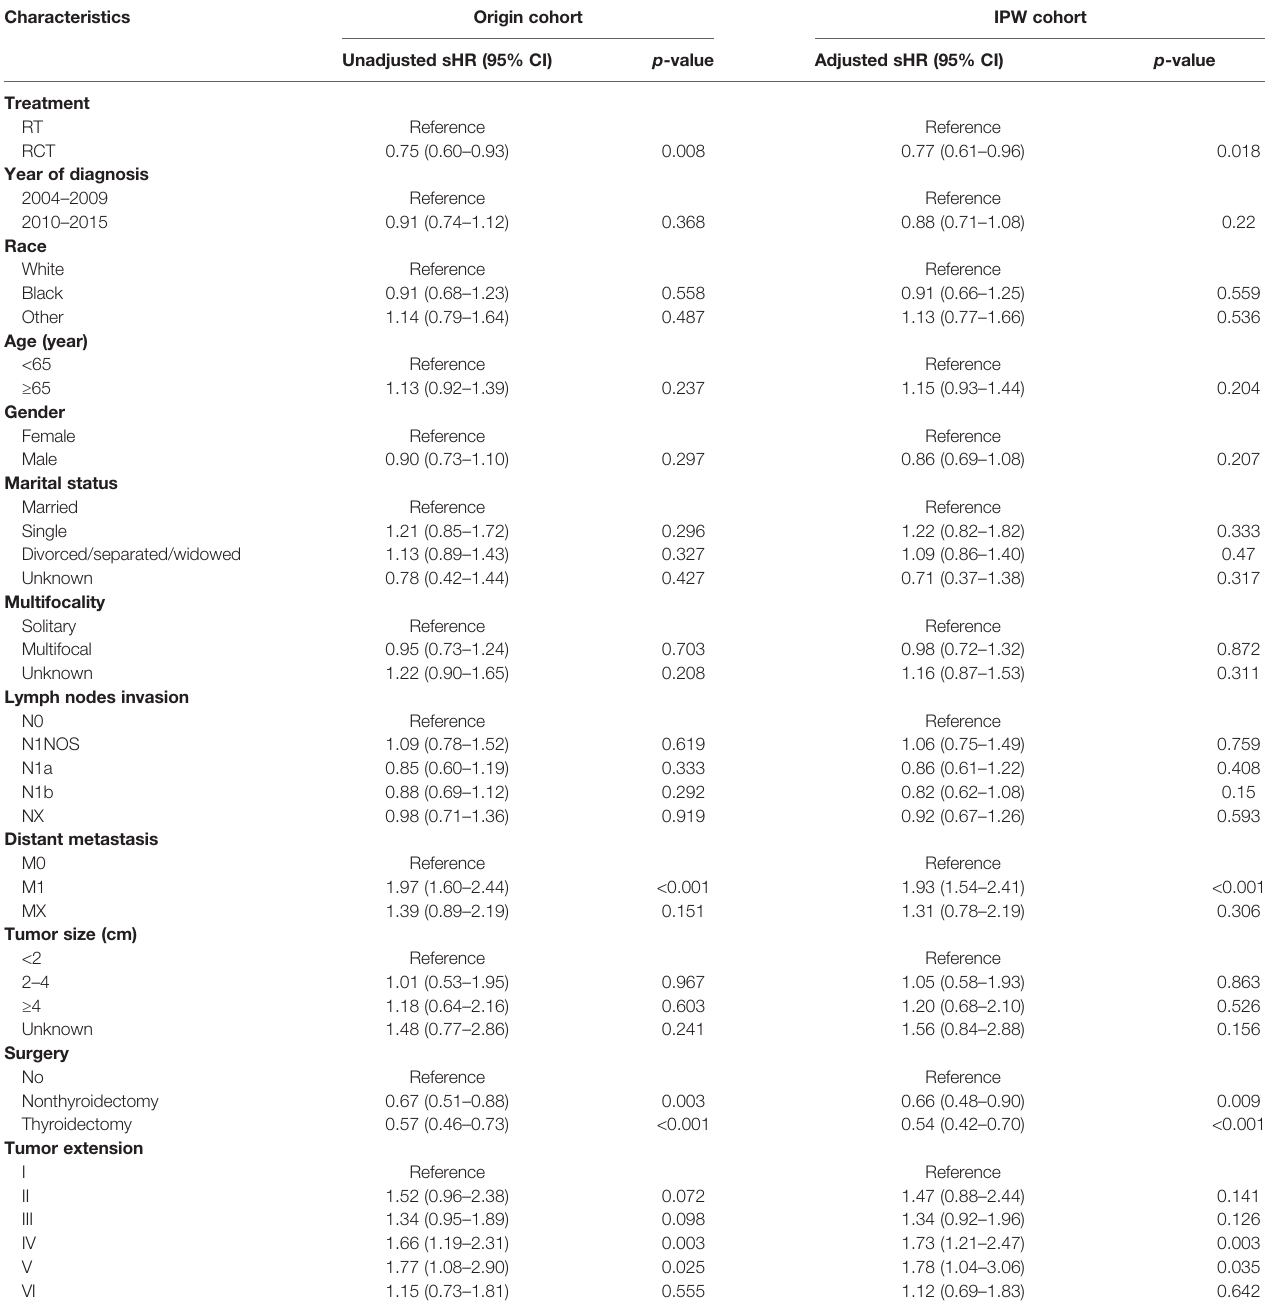
TABLE 3 | Multivariate Fine-Gray compete-risk model of cancer-speci fi c survival before and after inverse-probability weighting.